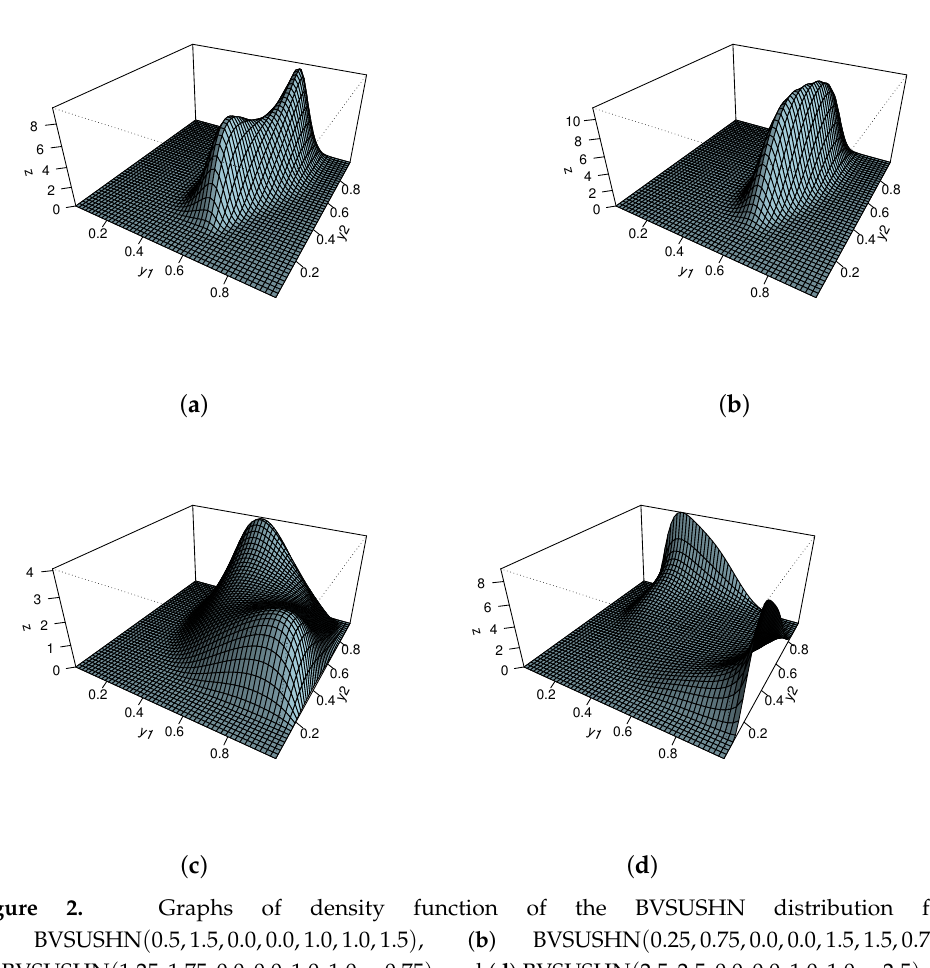
Figure 2. Graphs of density function of the BVSUSHN distribution for: ( a ) BVSUSHN ( 0.5,1.5,0.0,0.0,1.0,1.0,1.5 ) , ( b ) BVSUSHN ( 0.25,0.75,0.0,0.0,1.5,1.5,0.75 ) , ( c ) BVSUSHN ( 1.25,1.75,0.0,0.0,1.0,1.0, − 0.75 ) , and ( d ) BVSUSHN ( 2.5,2.5,0.0,0.0,1.0,1.0, − 2.5 )